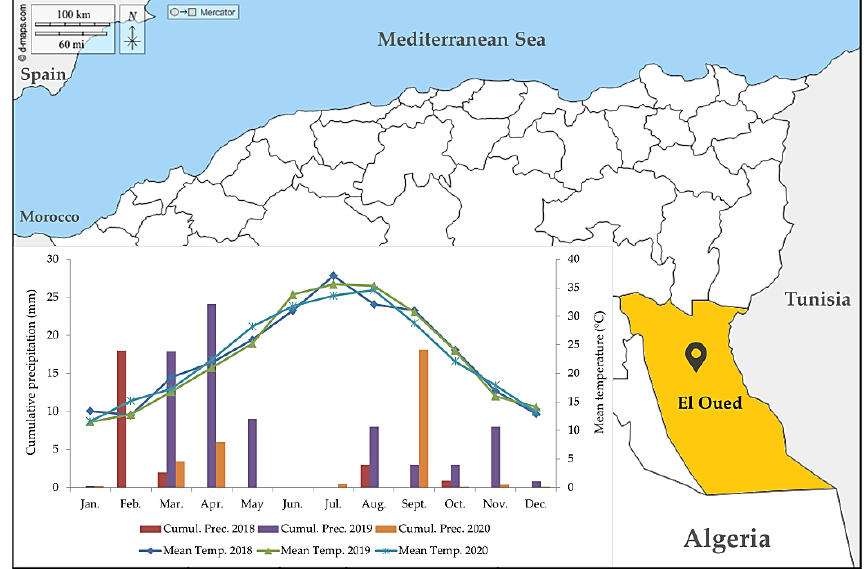
Figure 1. Geographical location and climatic data (2018–2020) of the wilaya of El